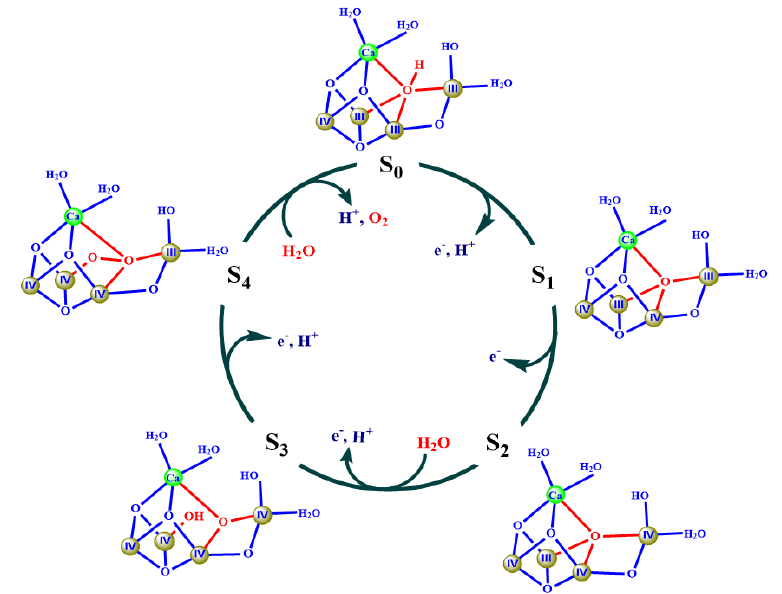
Figure 5. The third proposal for the O-O bond formation involving the µ 4 -oxide bridge (O5) [52,67,78]. All other depictions are the same as that in Figure 3. For clarity, all protein ligands of the OEC are omitted.